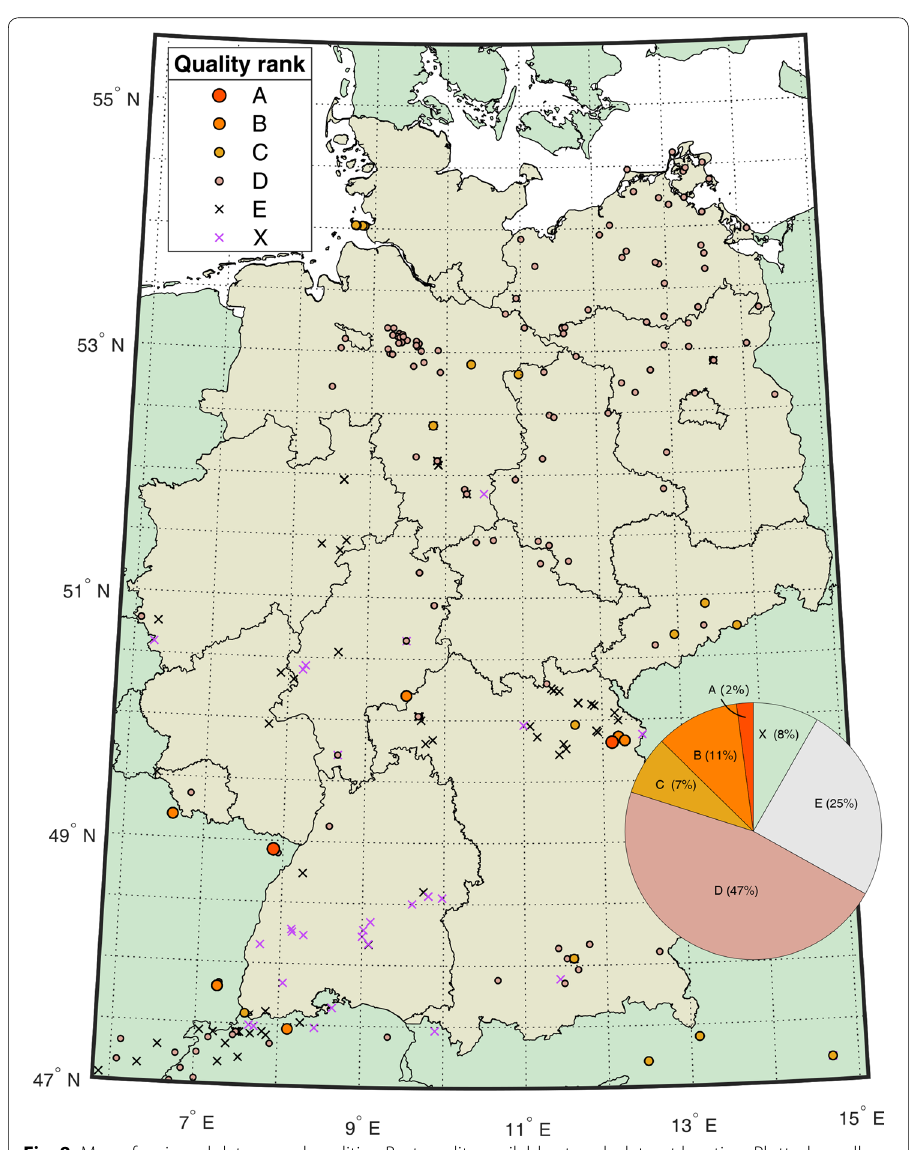
Fig. 8 Map of assigned data record qualities. Best quality available at each dataset location. Plotted are all data records in the database to which depth information is available ( n 564). Pie chart reflects proportions = of assigned qualities of all data records ( n =